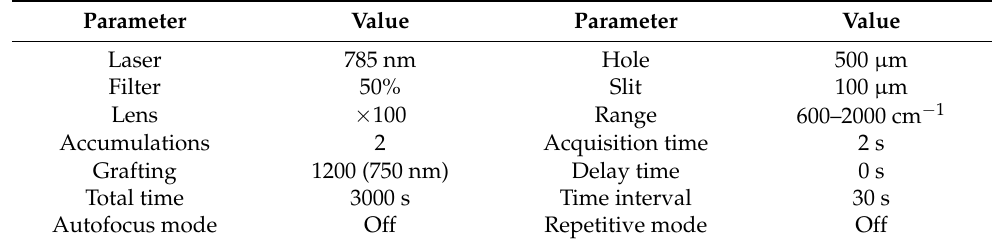
Table 1. Experimentally-determined parameters for Raman spectroscopy for monocomponent and reactive multicomponent in situ diffusion experiments.